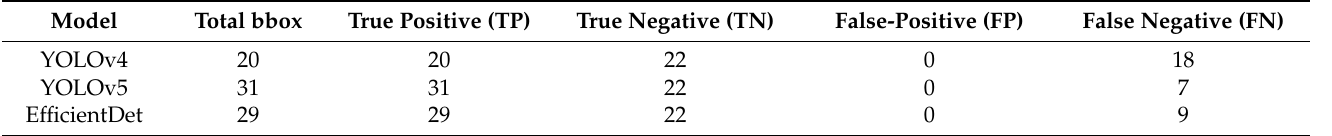
Table 6. Testing dataset metrics for accuracy performance evaluation.